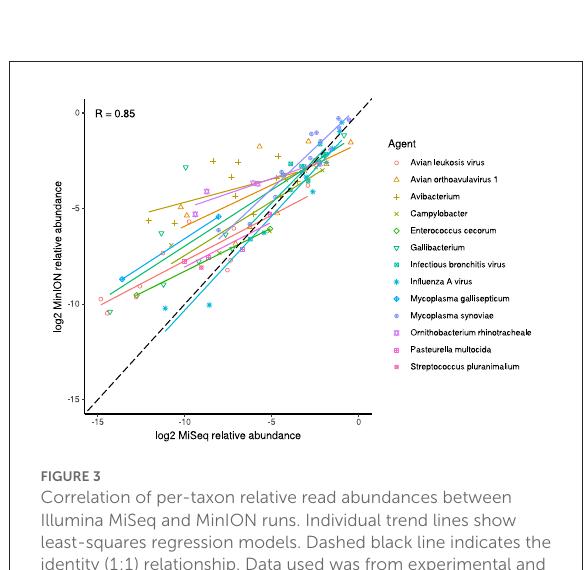
FIGURE4 Correlation of per-taxon relative read abundances between Illumina MiSeq and MinION runs of experimental samples. Individual trend lines show least-squares regression models. Dashed black line indicates the identity (1:1) relationship. Pearson’s R value is calculated from the combined dataset.